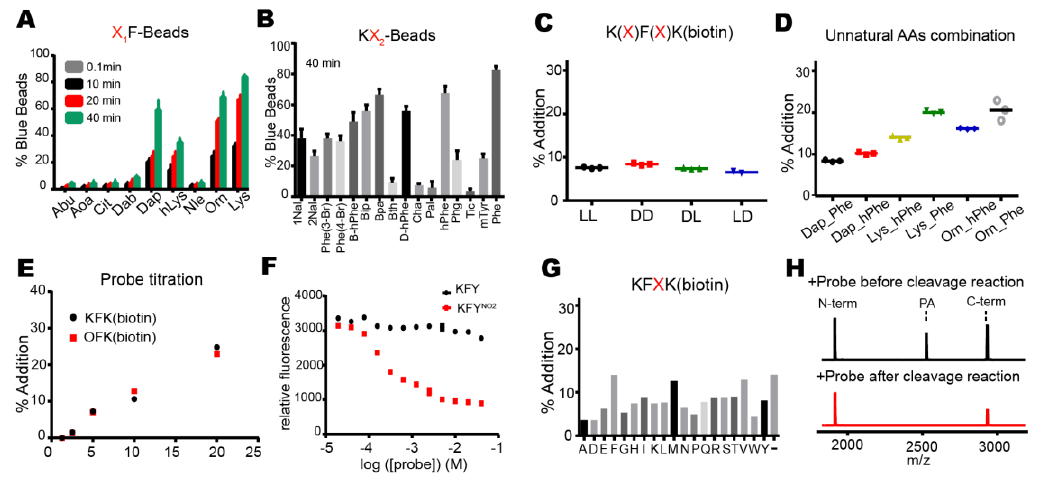
Figure 5. KFK(biotin) and OFK(biotin) are the best nucleophiles among those tested. ( A ) Various unnatural amino acids including the lysine mimics at the X 1 position of the X 1 F beads were tested for transpeptidation by the on-bead reactions (Abu, L -Aminobutyric acid; Aoa, L -Aminooxyacetic acid; Cit, L -Citrulline; Dab, L -Diaminobutyric acid; Dap, L -Diaminopropionic acid; hLys, L -Homolysine; Nle, L -Norleucine; Orn, L -Ornithine; Lys, L -Lysine). The error bars show averages ± 1 SD (n = 3). ( B ) Various unnatural amino acids mimicking phenylalanine at the X 2 position of the KX 2 beads were tested for transpeptidation by the on-bead reactions (1Nal, 1-Naphthyl- L -alanine; 2Nal, 2-Naphthyl- L -alanine; 3Br, 3-Bromo- L -phenylalanine; 4Br, 4-Bromo- L -phenylalanine; B-hPhe, L -beta-homophenylalanine; Bip, 4- L -Biphenylalanine; Bpa, 4- L -Benzoyl-phenylalanine; Bth, 3- L -Benzothiazolyl-alanine; D -hPhe, D -homophenylalanine; Cha, 3-Cyclohexyl- L -alanine; Pal, 4-Pyridyl- L -alanine; hPhe, L -homophenylalanine; Phg, L -Phenylglycine; Tic, 1,2,3,4-Tetrahydroisoquinoline-3-carboxylic acid; mTyr, O-methyl- L -tyrosine; Phe, L -Phenylalanine). The error bars show averages ± 1 SD (n = 3). ( C ) Four combinations of L - and D -amino acids in the KF dipeptide were tested for transpeptidation (10 µ M DegP and 100 µ M 18–58) in the context of KFK(biotin) (10 mM), and quantitatively analyzed by HPLC (n = 3). ( D ) Combinations of Dap, Lys, and Orn at the X 1 position with Phe and hPhe at the X 2 position were tested for transpeptidation (10 µ M DegP and 100 µ M 18–58) in the context of X 1 X 2 K(biotin) (20 mM), and they were quantitatively analyzed by HPLC (n = 3). ( E , G ) Transpeptidation reactions (10 µ M DegP and 100 µ M 18–58) were analyzed by HPLC with various concentrations (2.5–20 mM) of KFK(biotin) and OFK(biotin) (( E ); n = 1) or with 10 mM of KF X K(biotin), in which X represents various amino acids (( G ); n = 1). ( F ) The relative fluorescence of the p23 (Abz-GNWVSAA*KFEY NO2 SKNTQDYGILQI, where * is the cleavage site) cleavage reactions (1 µ M DegP and 40 µ M p23) was monitored in the presence of increasing amounts of the quencher probe (KFY NO2 ). The error bars show averages ± 1 SD (n = 3). Abz, 2-amino benzoic acid; Y NO2 , 3-nitrotyrosine. ( H ) KFK(biotin) (20 mM) was added before or after the cleavage reactions (5 µ M DegP and 50 µ M 18–58 in 20 µ L solution), and the reaction products were analyzed by MALDI-TOF-MS. Representative spectra are shown (n = 3).